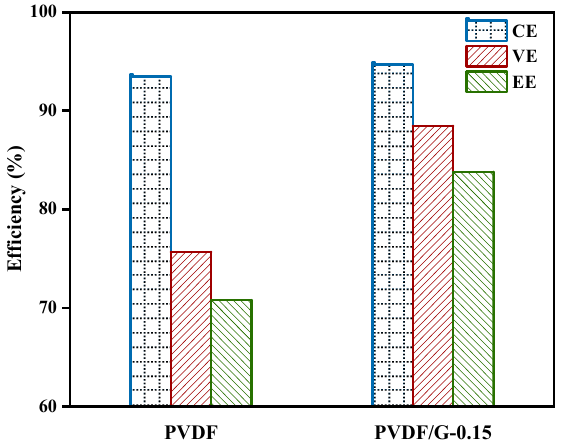
Figure 7. Battery efficiencies assembled with PVDF membranes and PVDF/G-0.15 membranes at 50 Figure 7. Battery e ffi ciencies assembled with PVDF membranes and PVDF / G-0.15 membranes at mA/cm 2 . 50 mA / cm 2 .